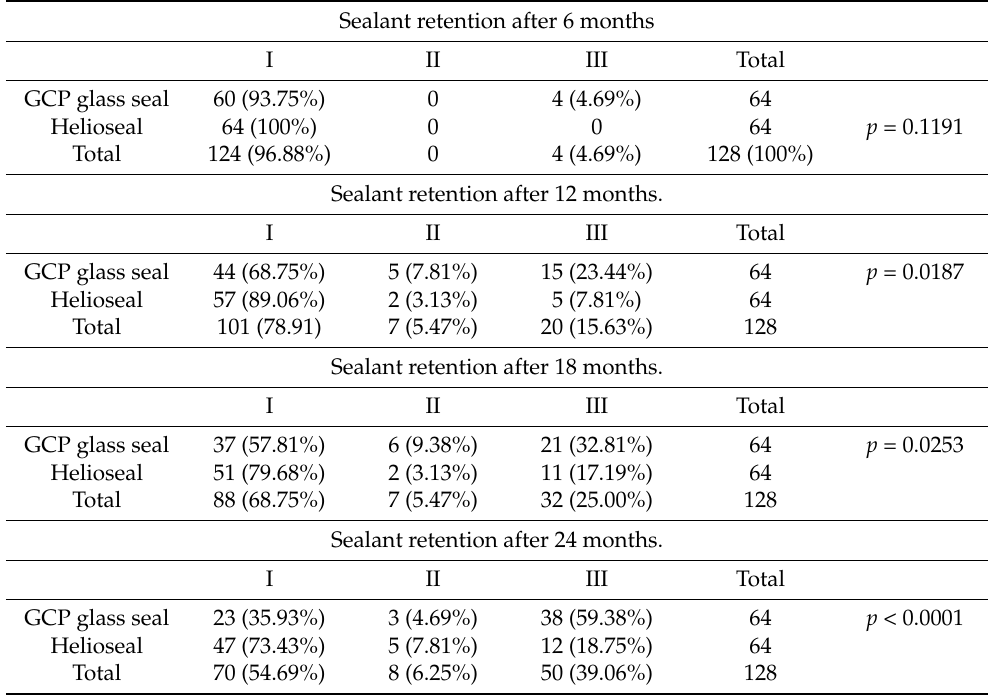
Table 1. Sealant retention rate after 6, 12, 18, and 24 months according to the evaluation criteria of